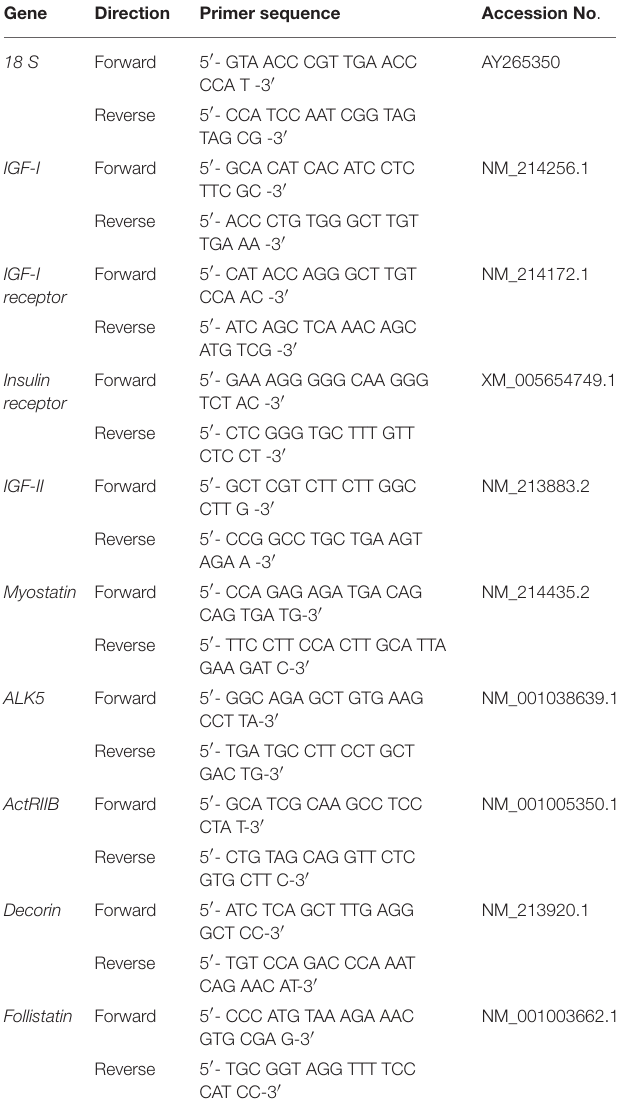
TABLE 1 | Nucleotide sequences of primers used for quantitative real-time PCR. Gene Direction Primer sequence Accession No